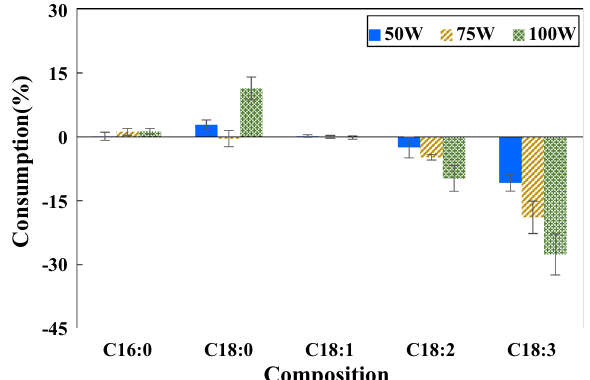
Figure 2. Effect of input power on FAME composition changes (1 mm gap and 25%H 2 at room temperature for 1